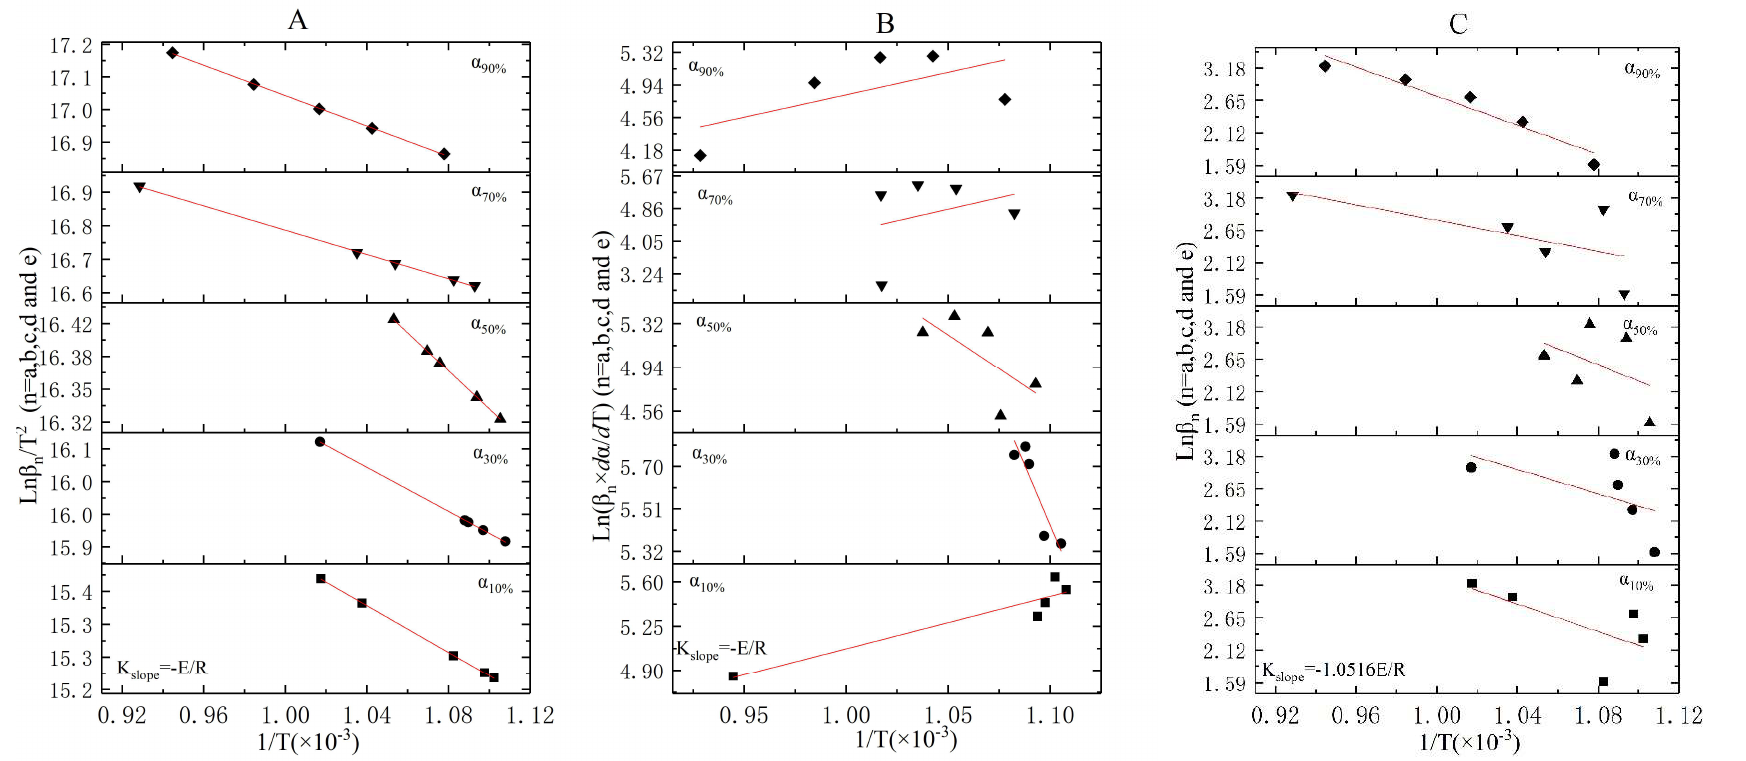
Figure 6 . The linear fitting results for Stage 4 under the KAS, Friedman, and FWO methods ( A —KAS method, B —Friedman method, and C —FWO method).